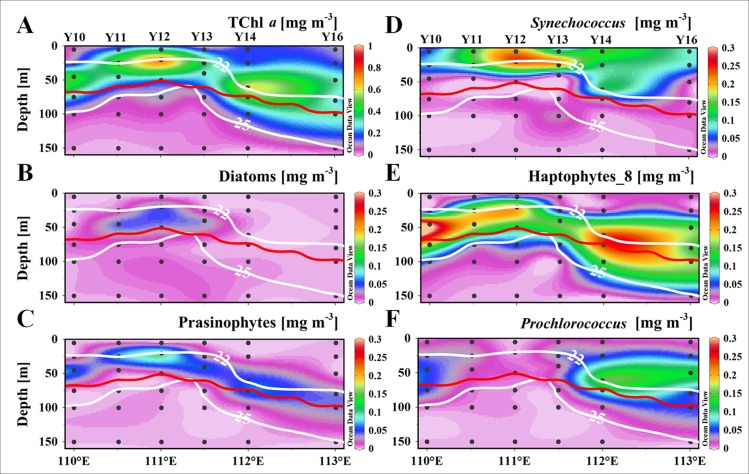
Vertical distribution of TChl a and major phytoplankton groups in terms of TChl a biomass [mg m-3] along section Y0 during the cruise.(A) TChl a, (B) Diatoms, (C) Prasinophytes, (D) Synechococcus, (E) Haptophytes_8, and (F) Prochlorococcus. The bright contours denote the isopycnals bordered between 22.0 kg m-3 and 25.0 kg m-3, and the intermediated red line is the euphotic depth [m].